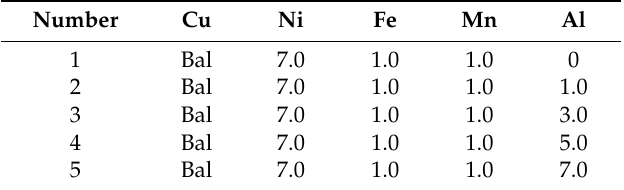
Table 1. The nominal chemical compositions of the designed copper alloys (wt %).